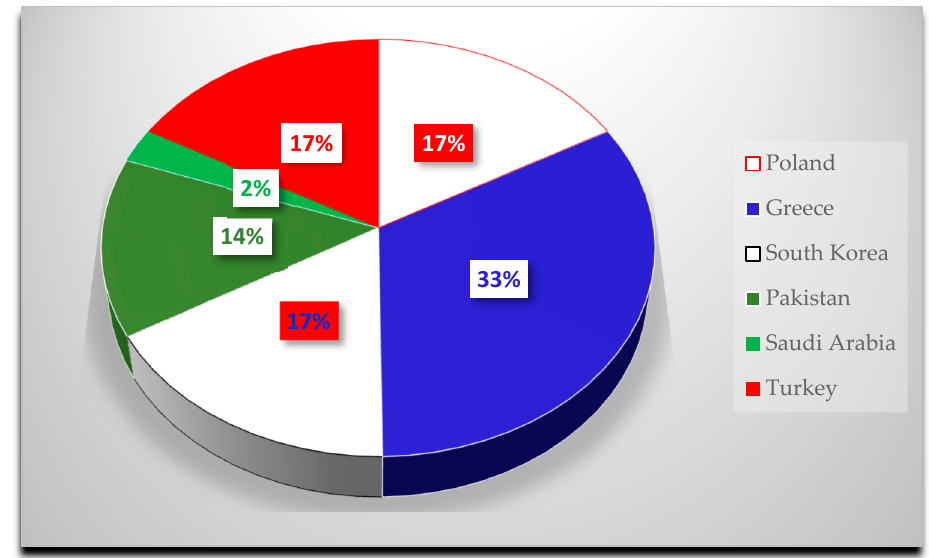
Figure 1. Geographical distribution of the published papers based on the country of institutes.